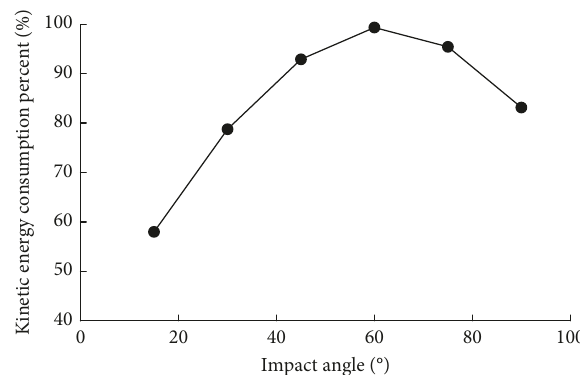
Figure 7: Ratio of kinetic energy consumption varies with the impact